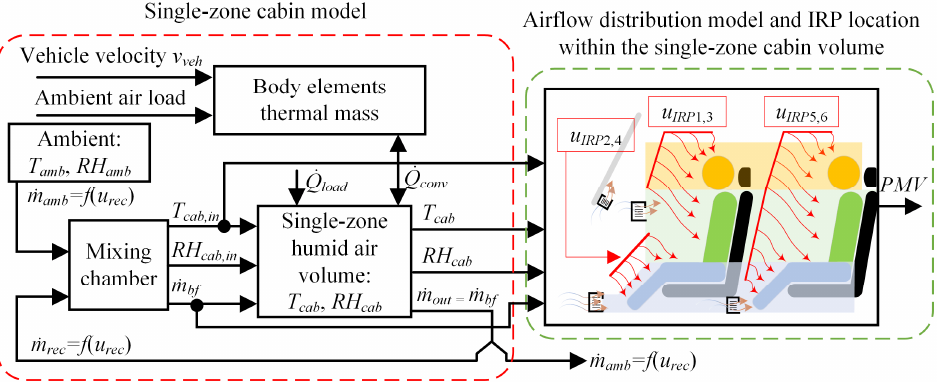
Figure 2. Block diagram of cabin thermal system model including airflow distribution model used for Predicted Mean Vote (PMV) evaluation.